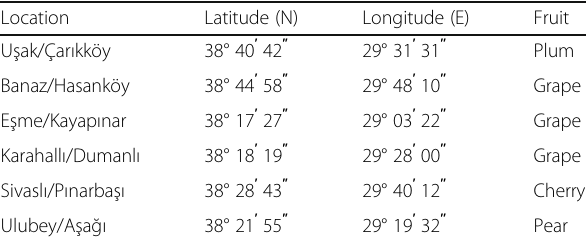
Table 1 Monitoring sites of prevalance of Drosophila suzukii